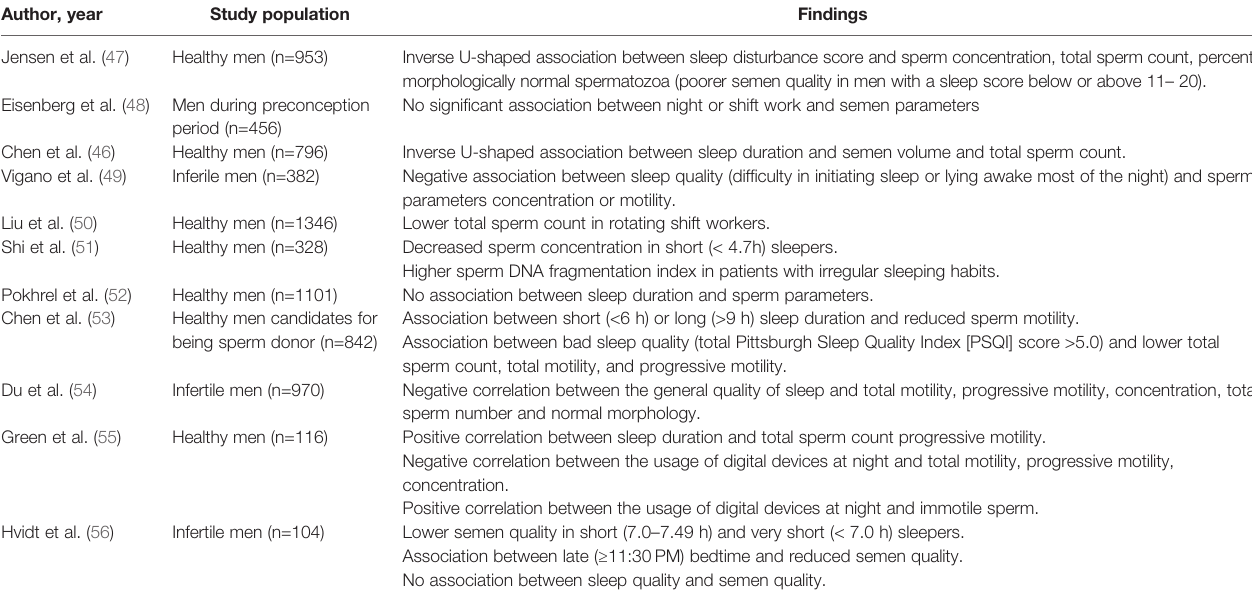
TABLE 2 | Findings from clinical studies investigating the association between sleep duration/quality and semen